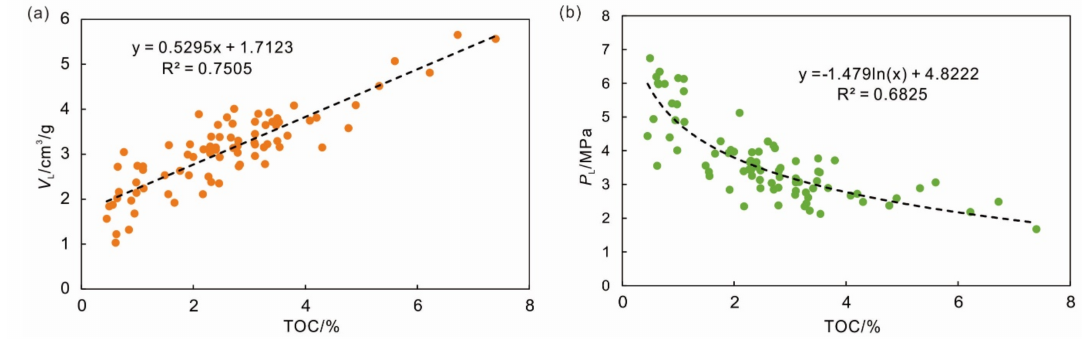
Figure 7. Relationships among the adsorption capacity ( V L ) ( a ), Langmuir pressure ( P L ) ( b ), and TOC of all the shale